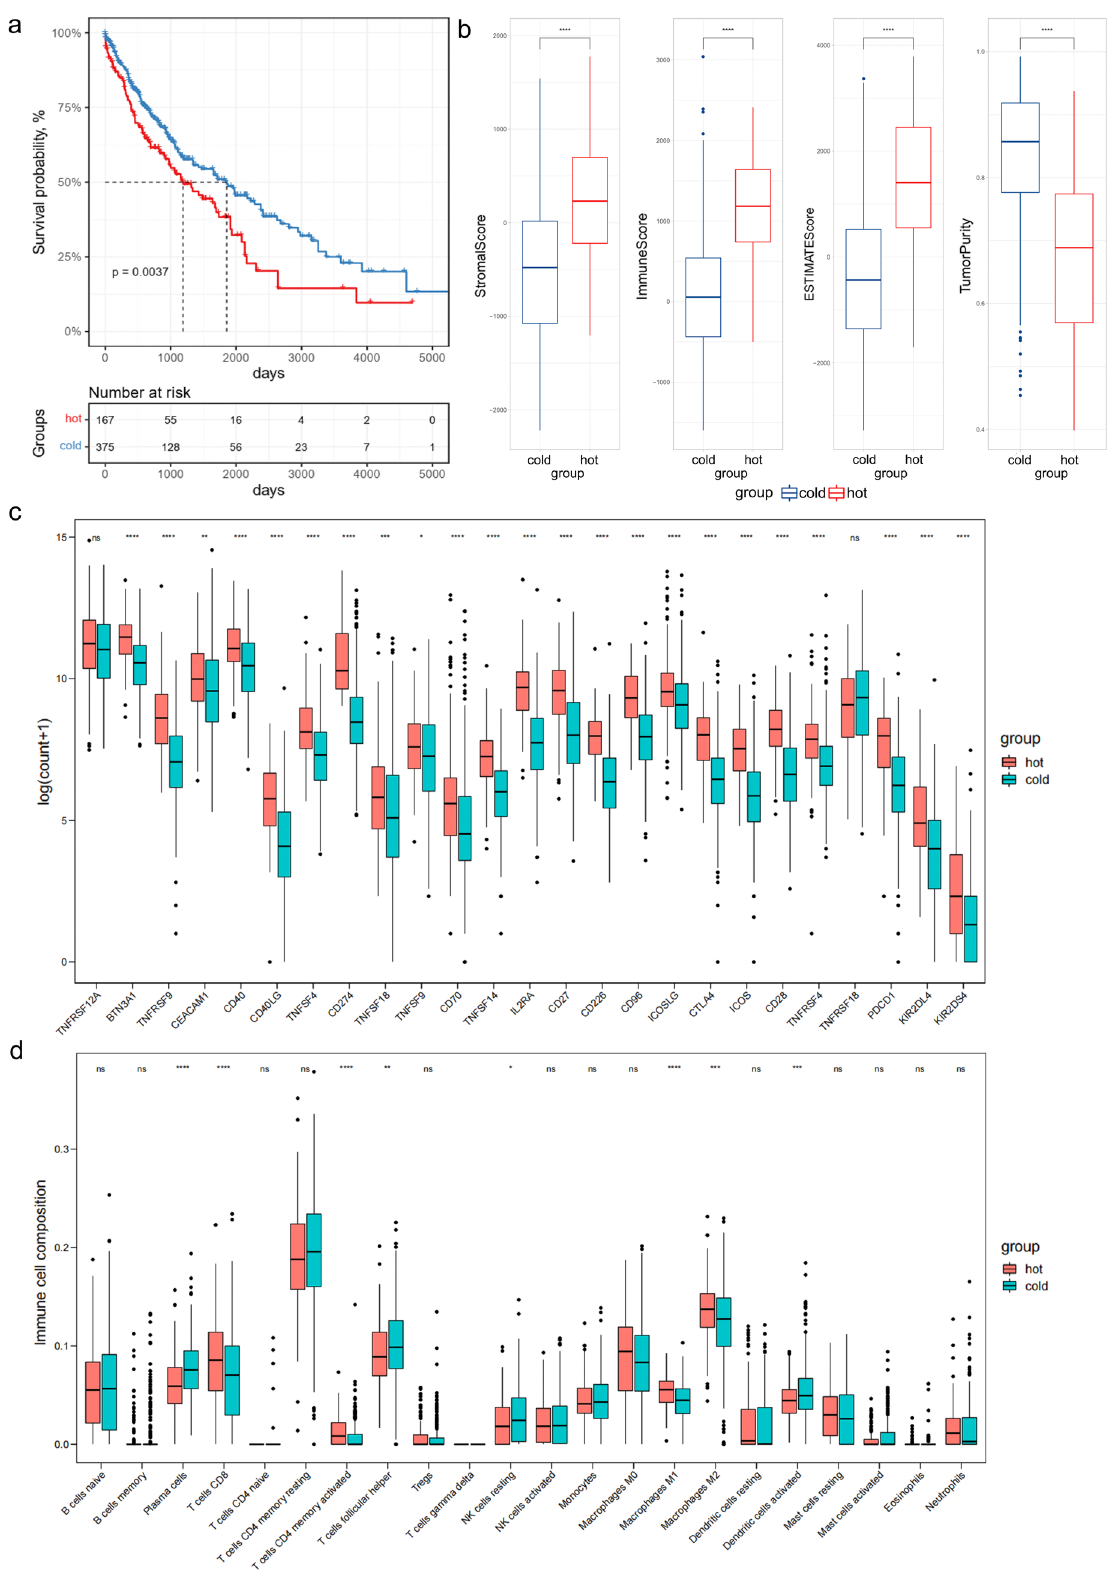
Figure 2. Stratification of hot and cold tumors. ( a ) The Kaplan–Meier curve shows the correlation between tumor stratification and overall survival. The p value is based on the log-rank test. ( b ) Immune score, stromal score, ESTIMATE score and tumor purity were obtained from ESTIMATE analysis in hot and cold tumors. ( c ) Expression of immune checkpoint molecules in hot and cold tumors. ( d ) Boxplot shows 22 immune cells infiltration obtained from CIBERSORT analysis in hot and cold tumors. *p < 0.05, **p < 0.01, ***p < 0.001, ****p < 0.0001, hot hot tumors, cold cold